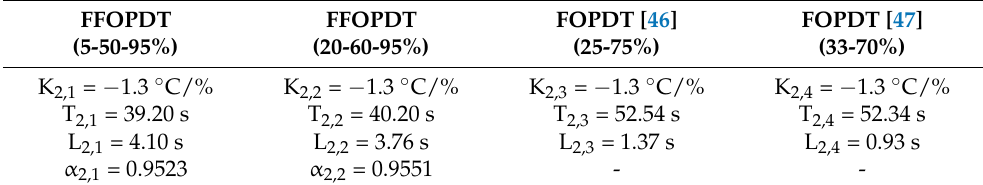
Table 10. Model parameters obtained using the considered identification method for FFOPDT models using (5-50-95%) and (20-60-95%), and the ones using identification methods proposed by Alfaro and Viteckov á for FOPDT